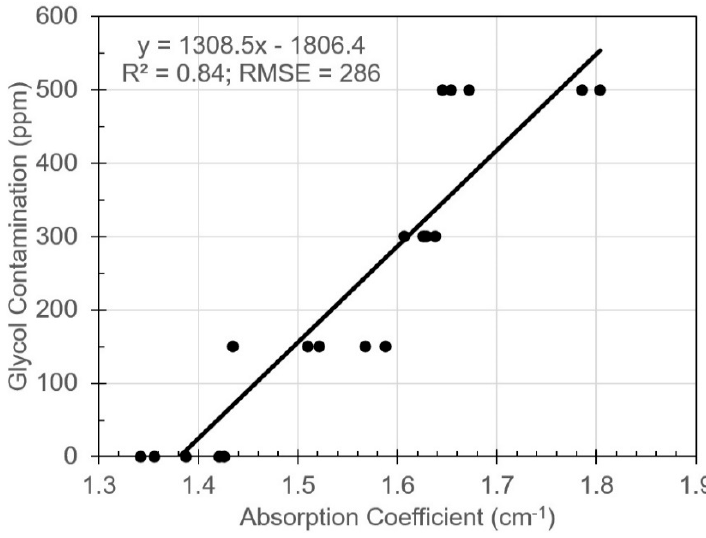
Figure 4. Absorption coefficient at 1.75 THz predicting glycol contamination (ppm) with a linear model.